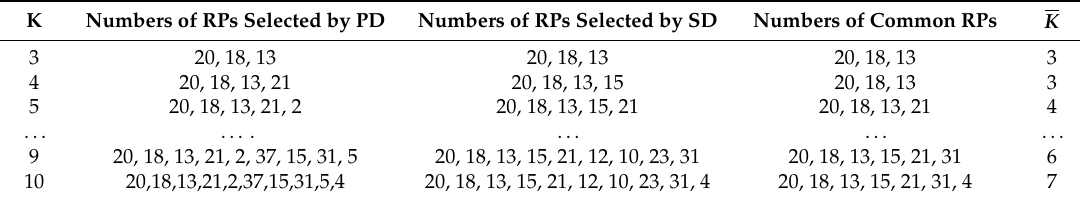
Table 1. The selection of the common reference points